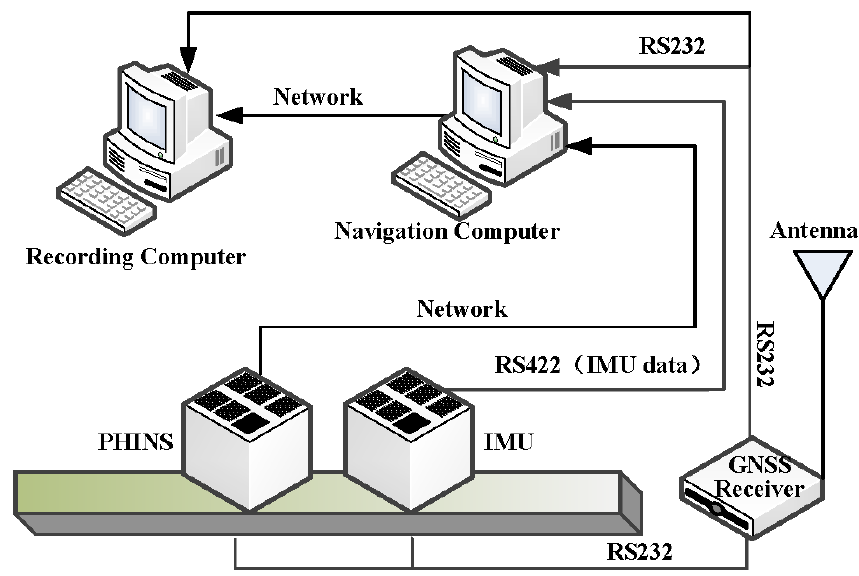
Figure 3. Structure diagram of vehicle-mounted experiment.